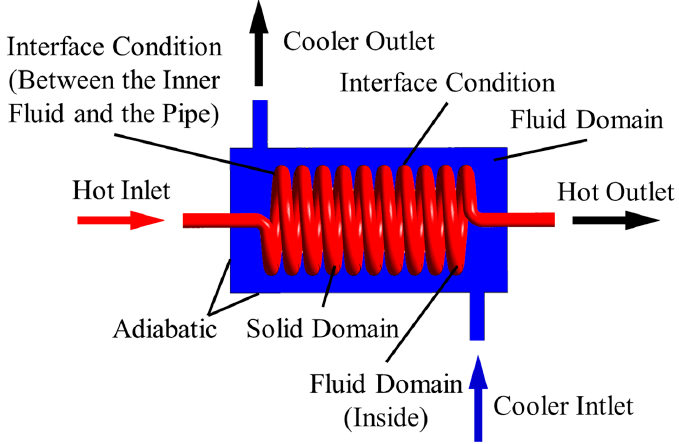
Figure 3. Computational domain and boundary conditions.